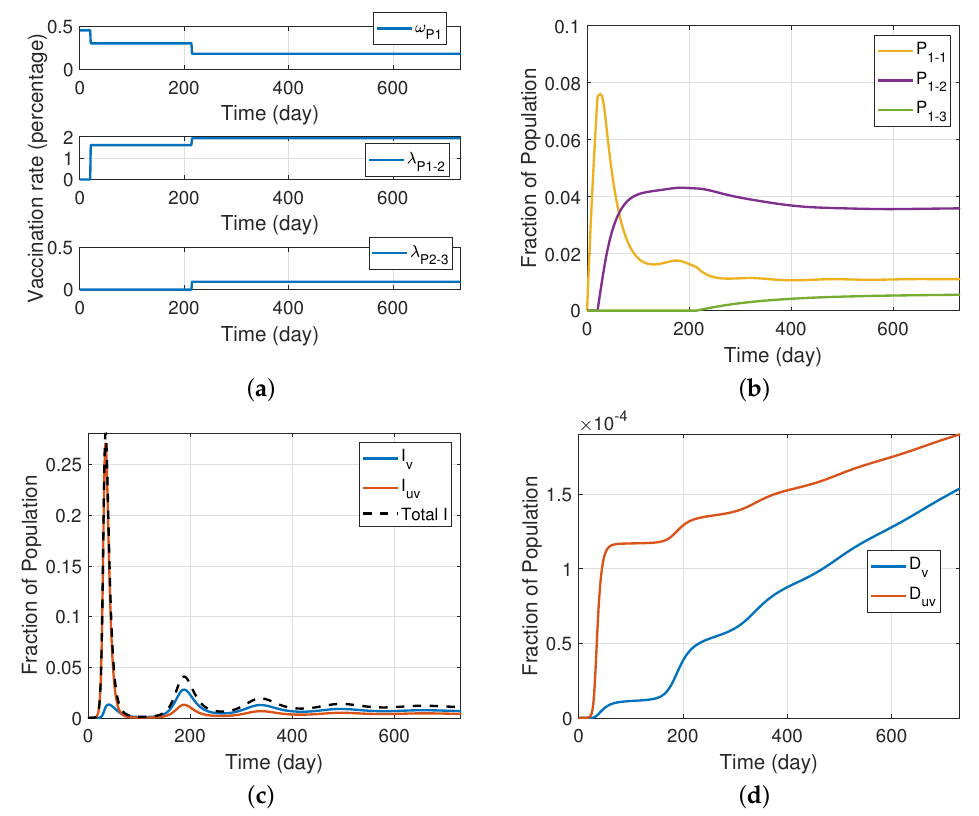
Figure 11. An SIRS model with a three-dose vaccine and different vaccinated and unvaccinated compartments (model depicted in Figure 10), assuming that vaccination with the Pfizer vaccine is available from the beginning; ( a )vaccination rates of first dose, second dose, and third dose from top row to bottom row, respectively; ( b ) fraction of individual protected by one, two, and three doses of a vaccine; ( c ) fraction of infectious individual; ( d ) fraction of deceased